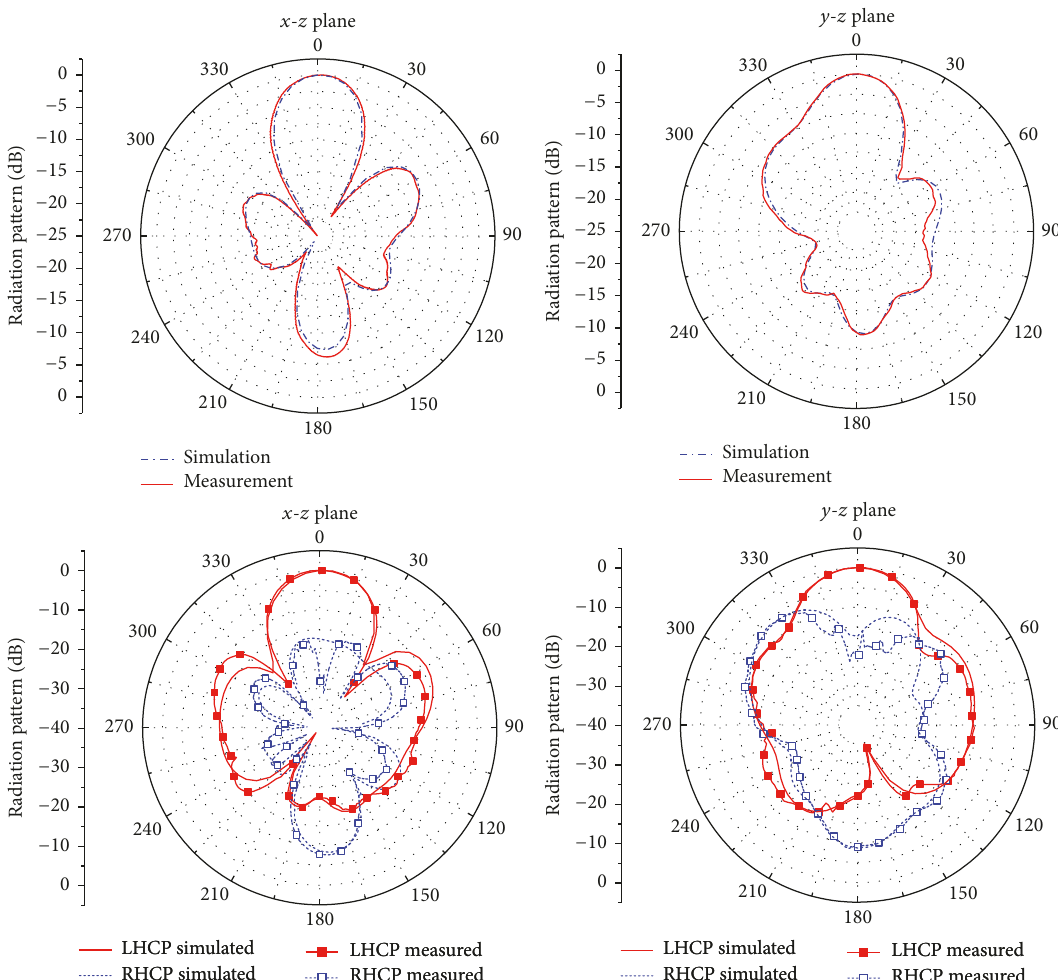
Figure 13: Measured and simulated radiation patterns and the copolar and cross-polar components of the 2 × 2 array.